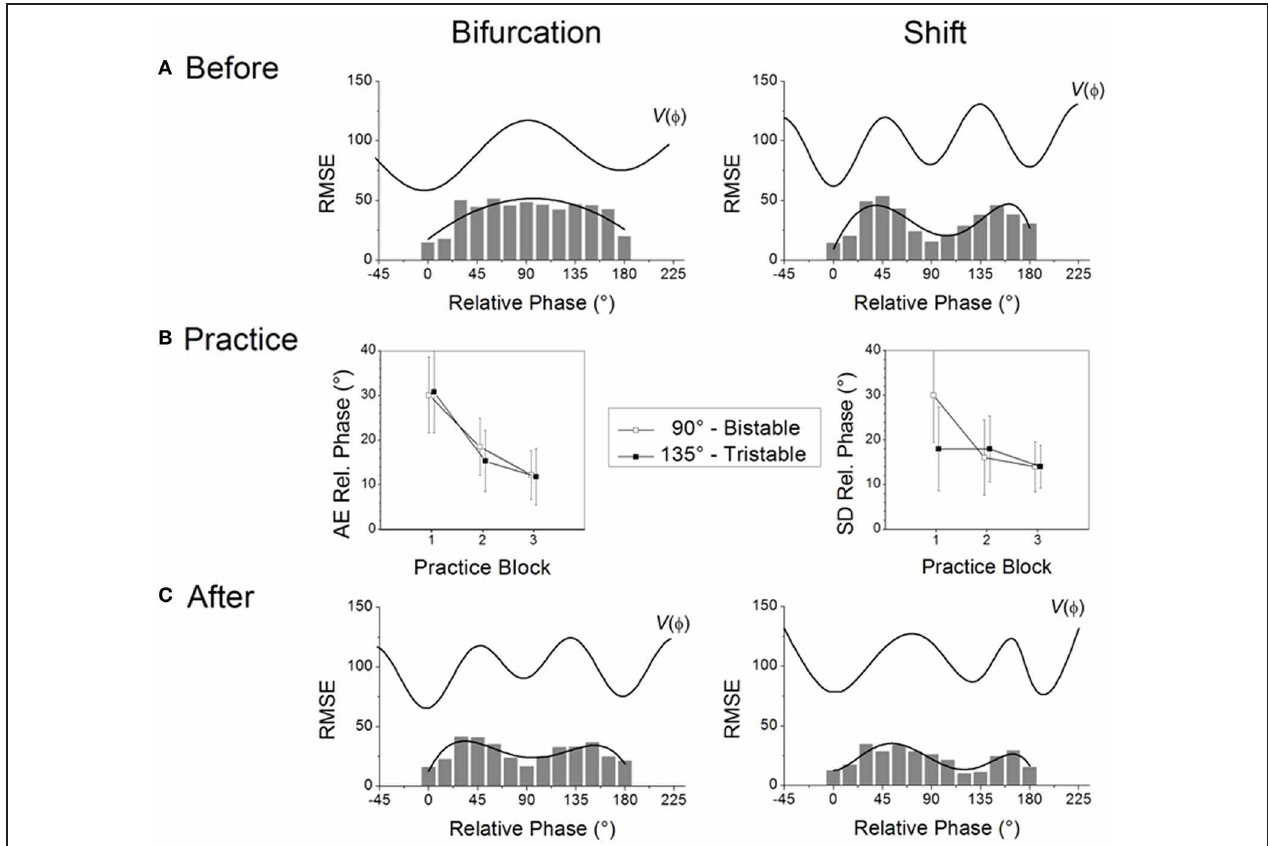
FIGURE 1 | Two routes to learning. See text for details. (Data adapted from Kostrubiec et al.,